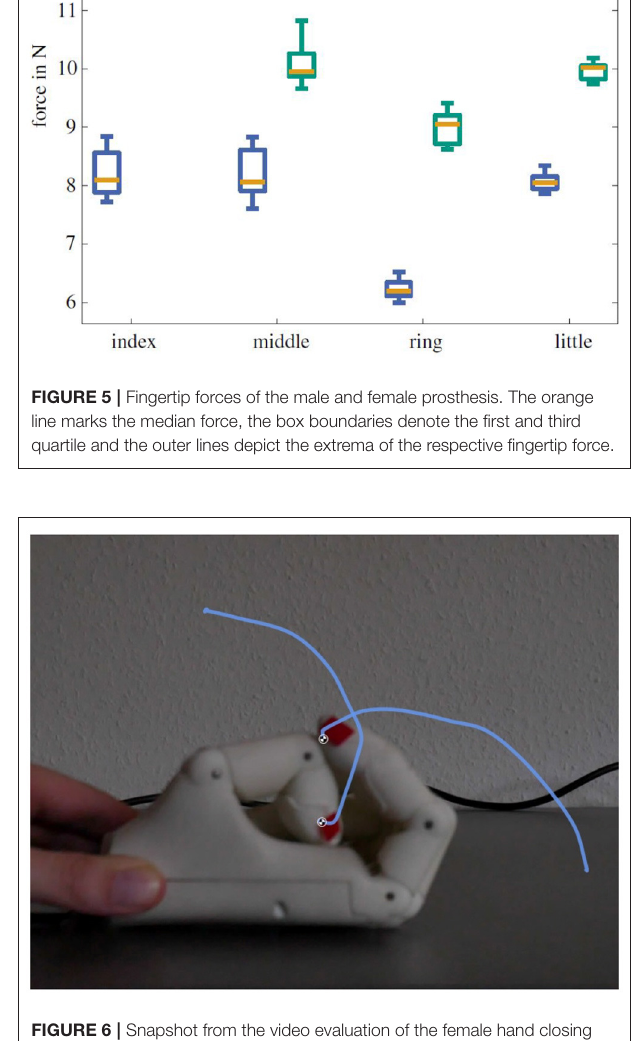
FIGURE 6 | Snapshot from the video evaluation of the female hand closing speed. Red markers on thumb and index finger are tracked in the video sequence, blue lines indicate the closing trajectories of these two